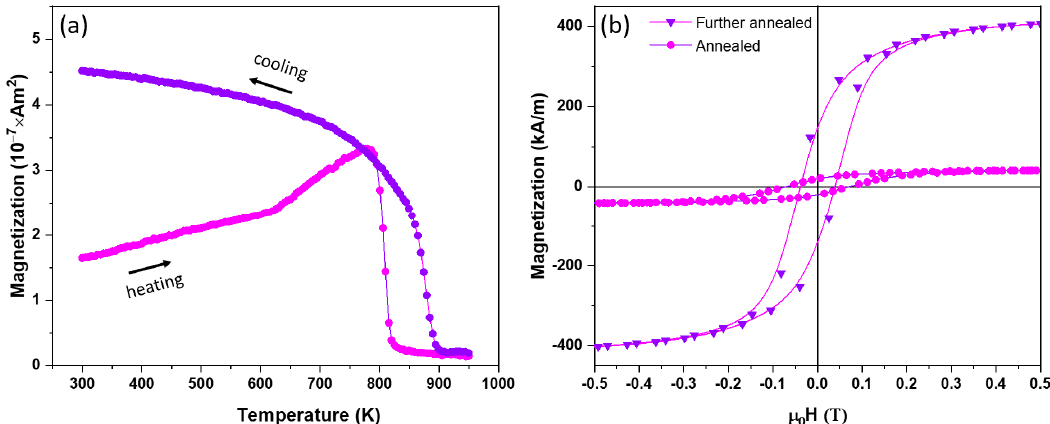
Figure 7. Magnetic properties of the annealed and further annealed NPs: ( a ) M vs. T data of the annealed NPs; and ( b ) hysteresis loops of the annealed and further annealed NPs at 300 K.